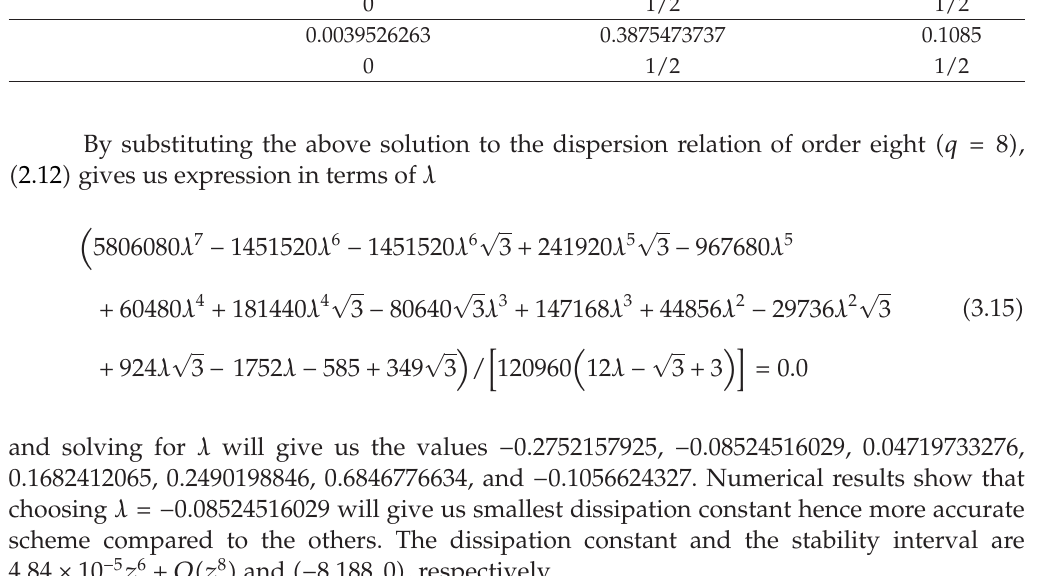
− 0 . 2031515178 0.02063526960 √ 1 / 2 − 3 /